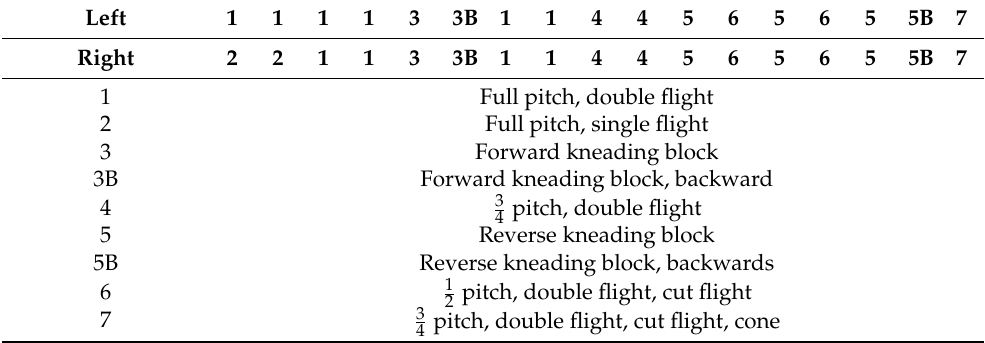
Table 4. Extruder screw configuration. The two screws differed only in the first two feeding elements.